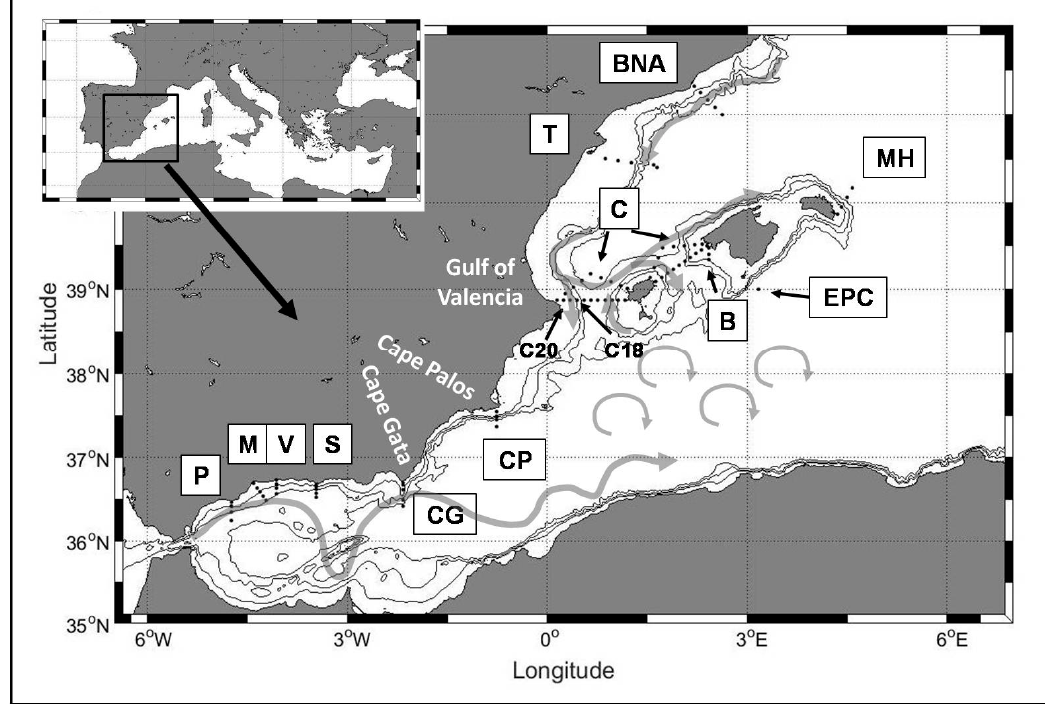
Figure 1. RADMED transects and stations. Grey lines are the basic features of the surface layer circulation (0–150